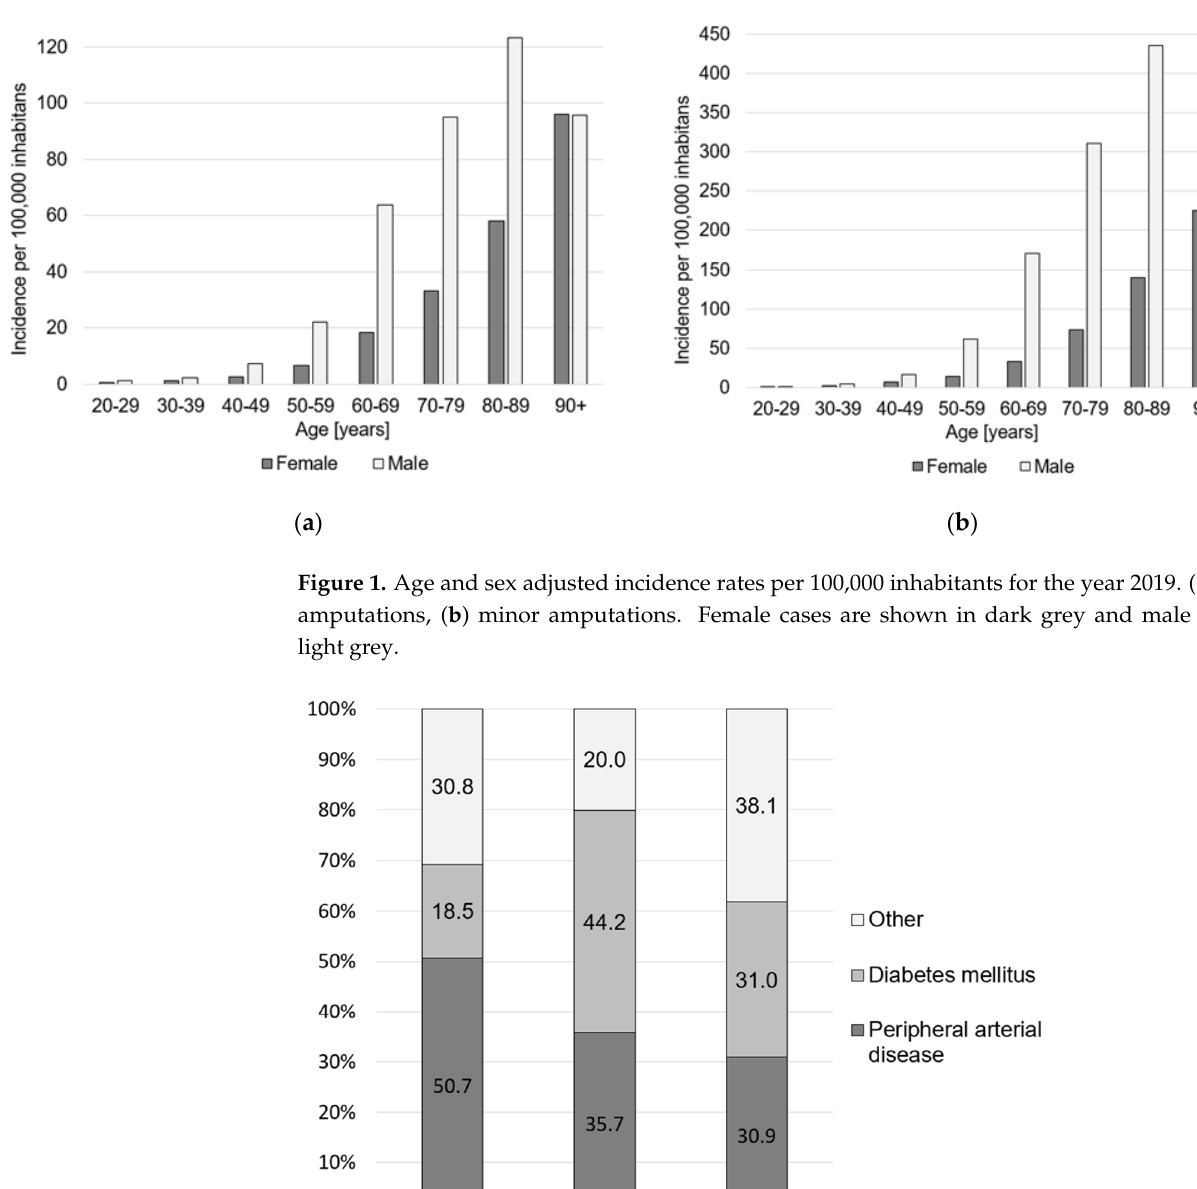
Table 4. Incidence rates of revision amputation procedures performed in the year 2019 divided by anatomical localization.